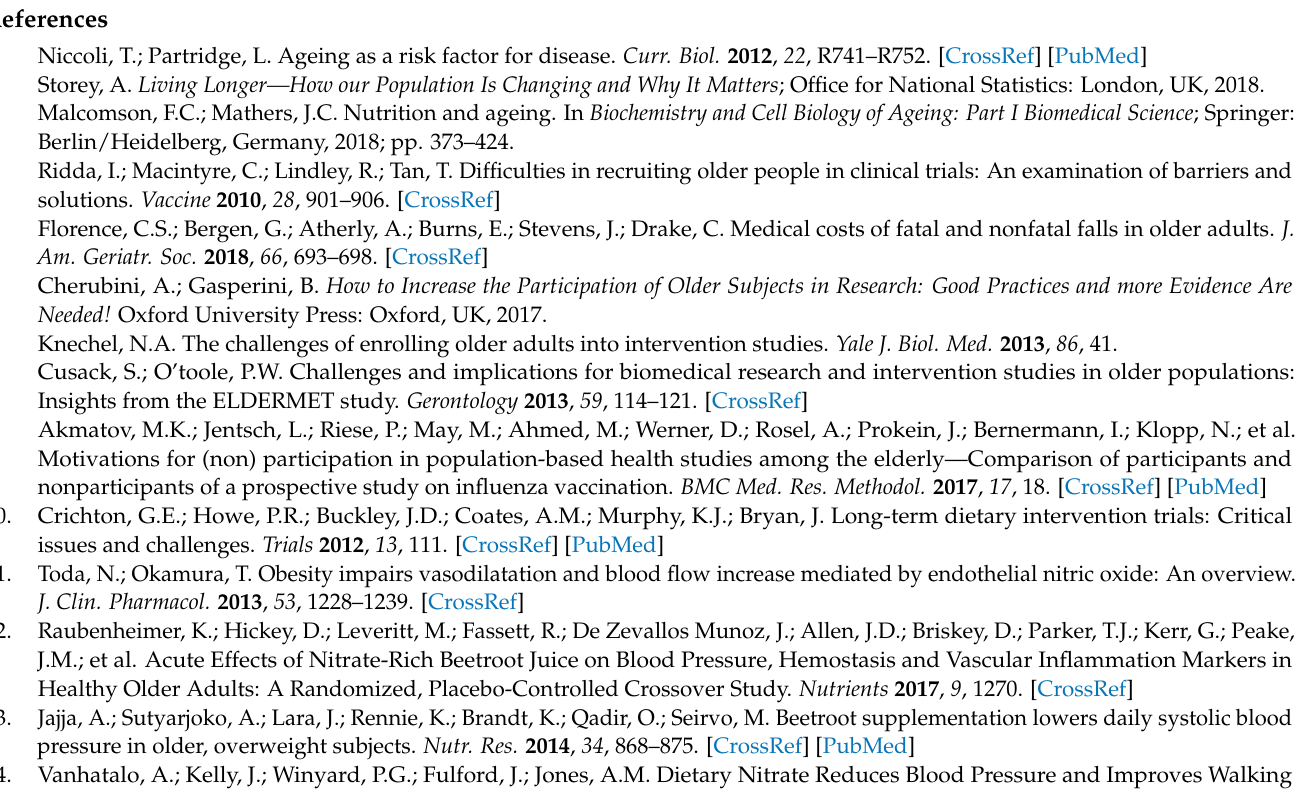
Figure S5: Mean of urinary NO 3 − concentrations in the LN group (low NO 3 − dose; 70 mL of BJ every alternate days), Figure S6: Scatterplot of Pearson correlation between Berkeley salivary NO 2 − strips readings and salivary NO 2 − concentrations. Figure S7: Salivary NO 2 − , NO 3 − and urinary NO 3 − (C) concentrations. Feedback questionnaire. Supplemental methods. Figure S8: Mean of salivary NO 3 − concentrations after removing data from one